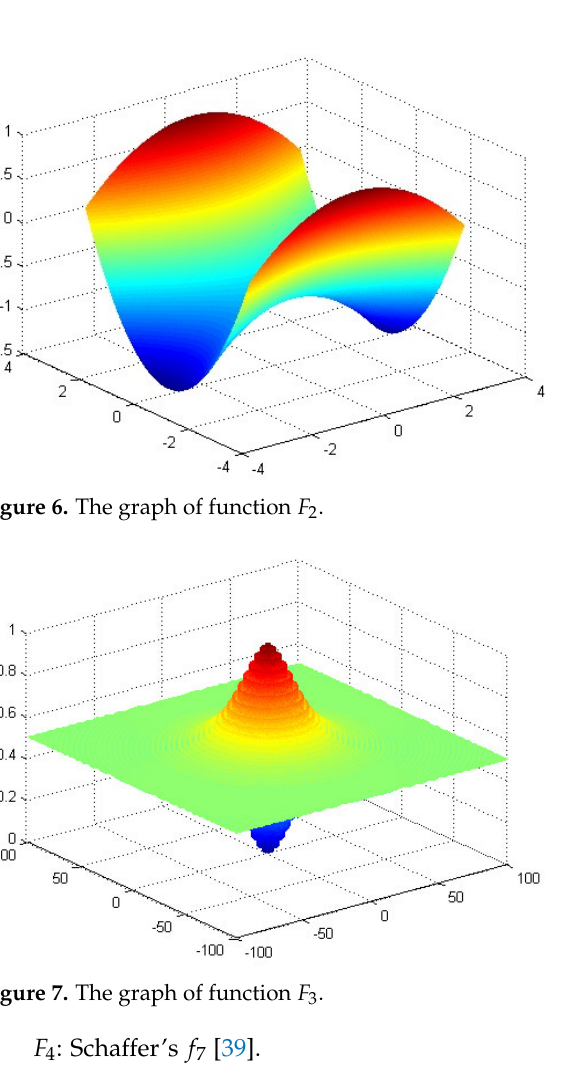
This function is similar to F 3 , and its global minimum is F 4 (0, 0) = 0. The graph of F 4 is shown in Figure 8.